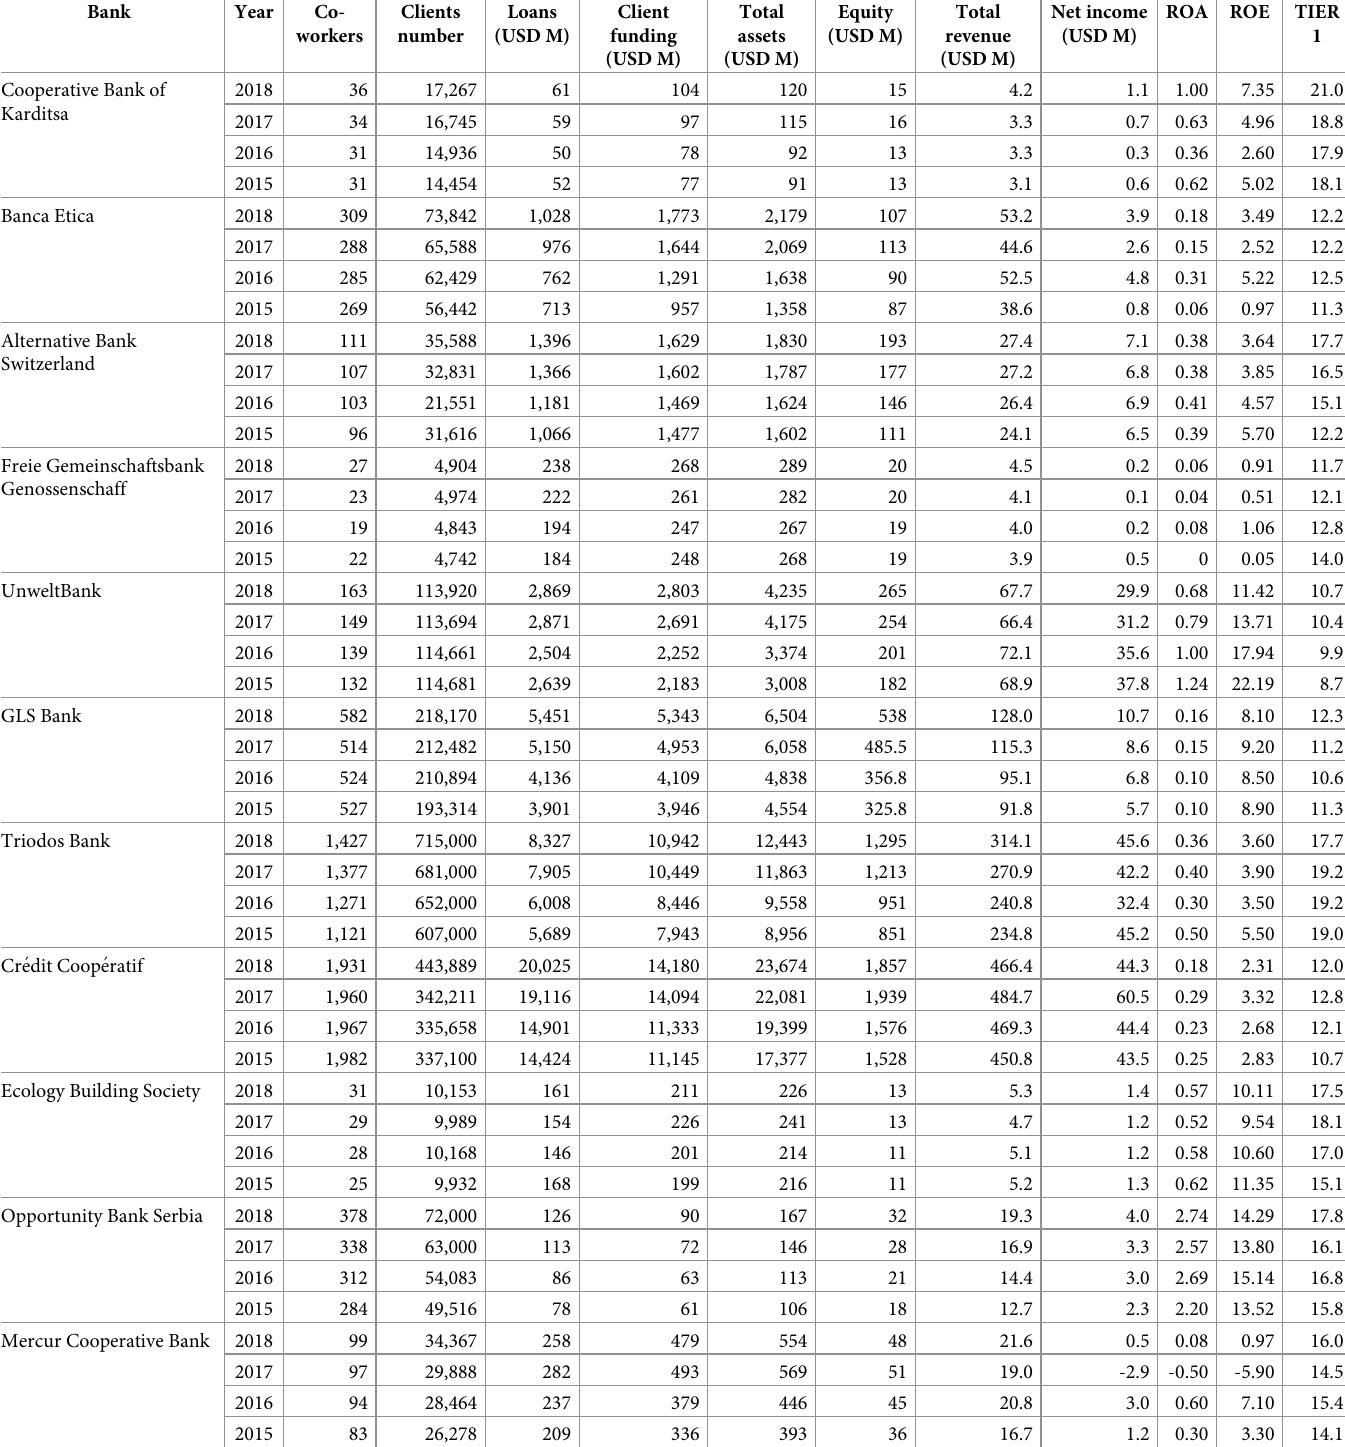
Table 2. Key figures of European banks included in the Global Alliance for Banking on values.